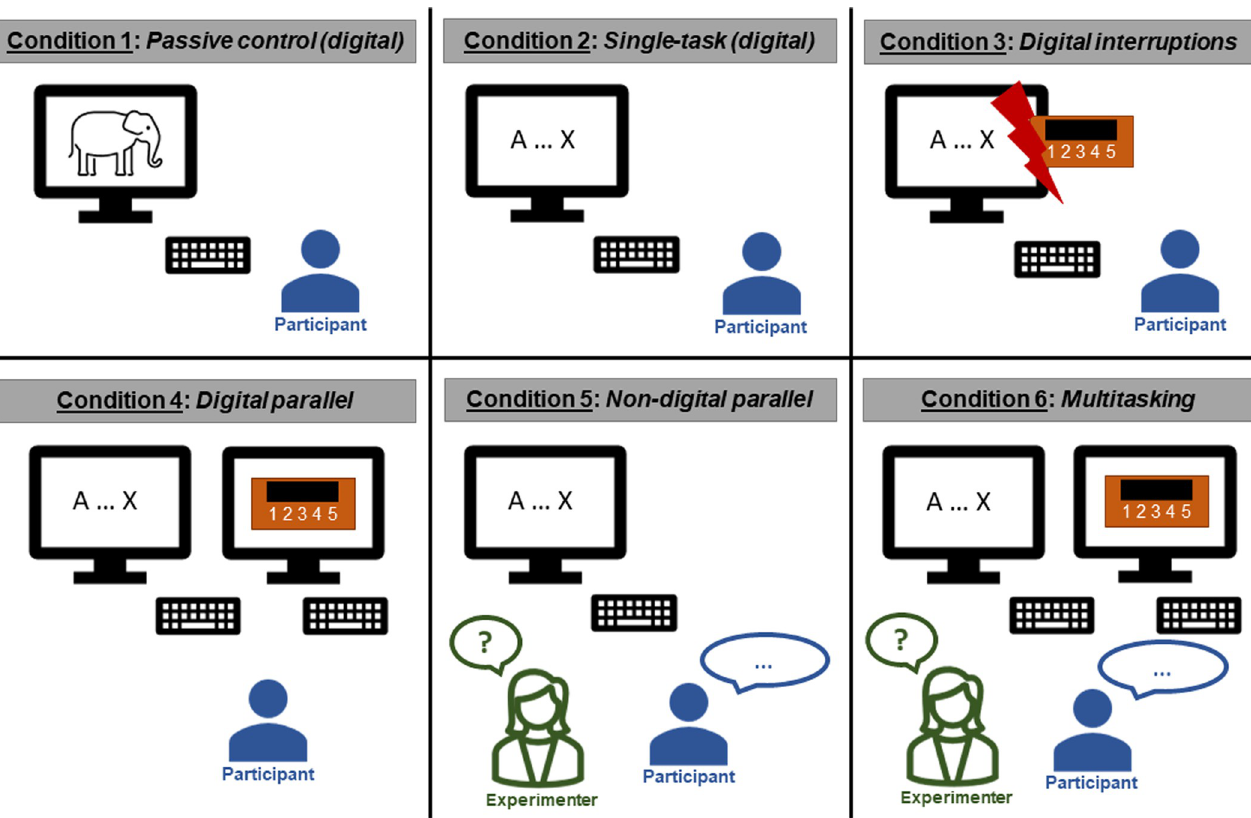
Fig 1. Experimental conditions. Each participant will be randomly assigned to one of the six experimental conditions. In condition 5 and 6, an experimenter will be present in the same room as the participant to introduce a non-digital, social-evaluative stress component.